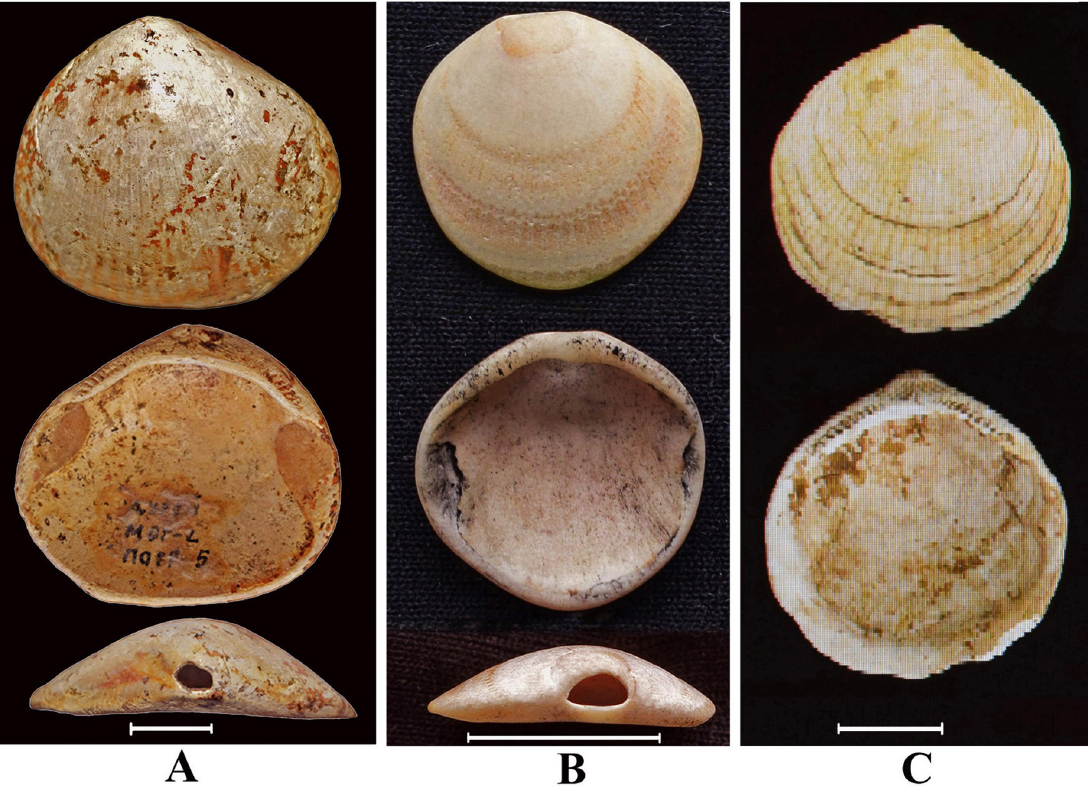
Fig 9. Archaeological specimens and recent shells of Glycymeris . Outside, inside and dorsal views: A – G . cf. yessoensis from the Duroy burial ground in Transbaikalye, B –recent G . yessoensis from the Amursky Bay (Sea of Japan/East Sea), the hole in the umbonal area of valve (dorsal view); C – G . yessoensis from excavation of the medieval settlement Nikolaeskoe I in the Primorye, Russian Far East [39]. Scale bar 1 cm.